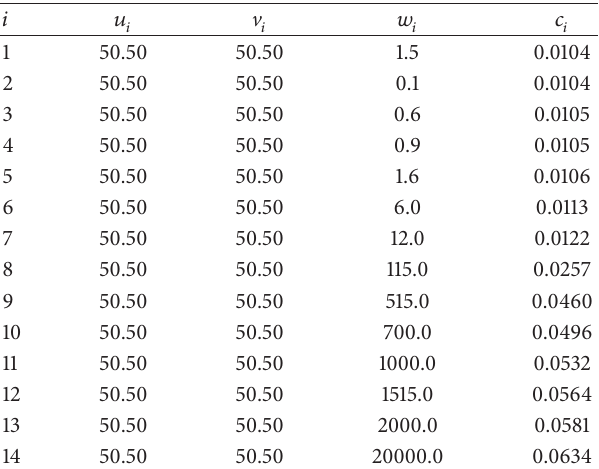
Table 11: Values of 𝑐 𝑖 with different values of shape parameters 𝑢 𝑖 , V 𝑖 , and 𝑤 𝑖 .